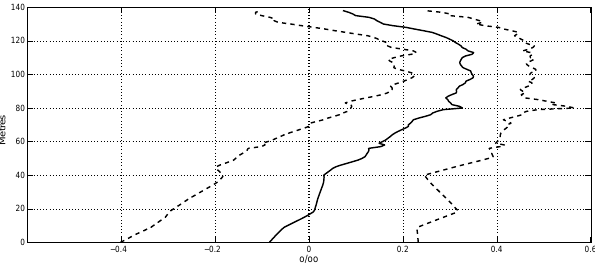
Figure 6. The mean of four core δ 18 O values and their formal stan- dard deviation with 3 degrees of freedom. Values differ from zero at 1 standard deviation only in the interval from about 10 to 70m depth. Only the top 100m of data are used in the analysis